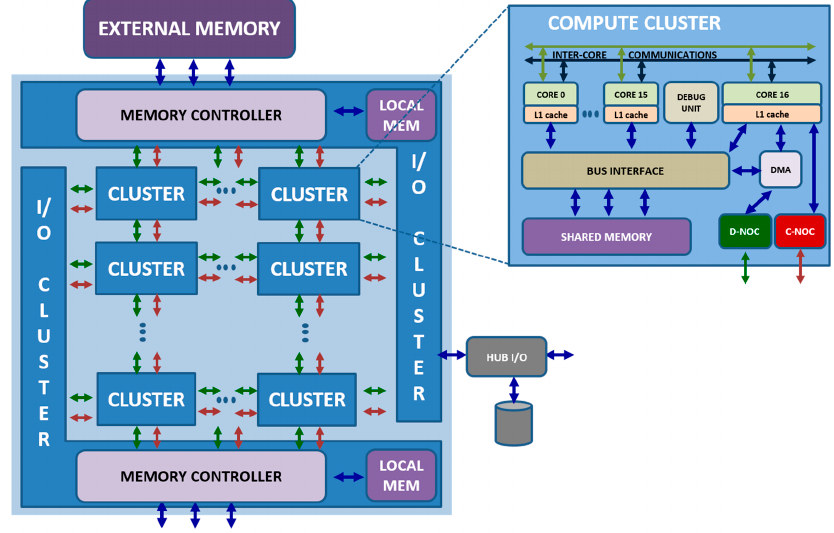
Figure 1. Many-core processor components. MPPA-256 has 2 IO clusters and 16 Compute Clusters.